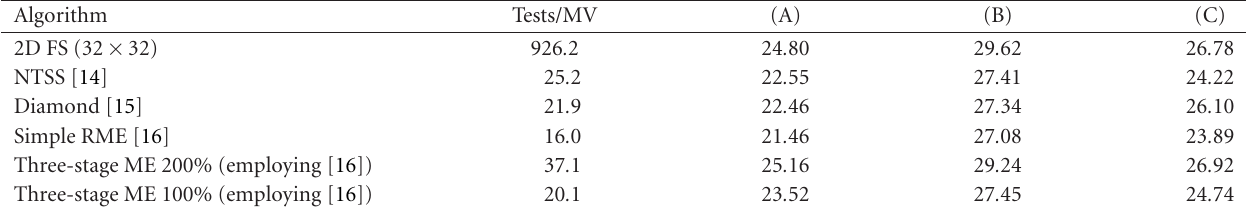
Table 2: Average luminance PSNR of the motion-compensated P- and B-frames for sequences “Stefan” (A), “Renata” (B), and “Teeny” (C) with di ff erent ME algorithms. The second column shows the average number of SAD-based vector evaluations per MV (based on